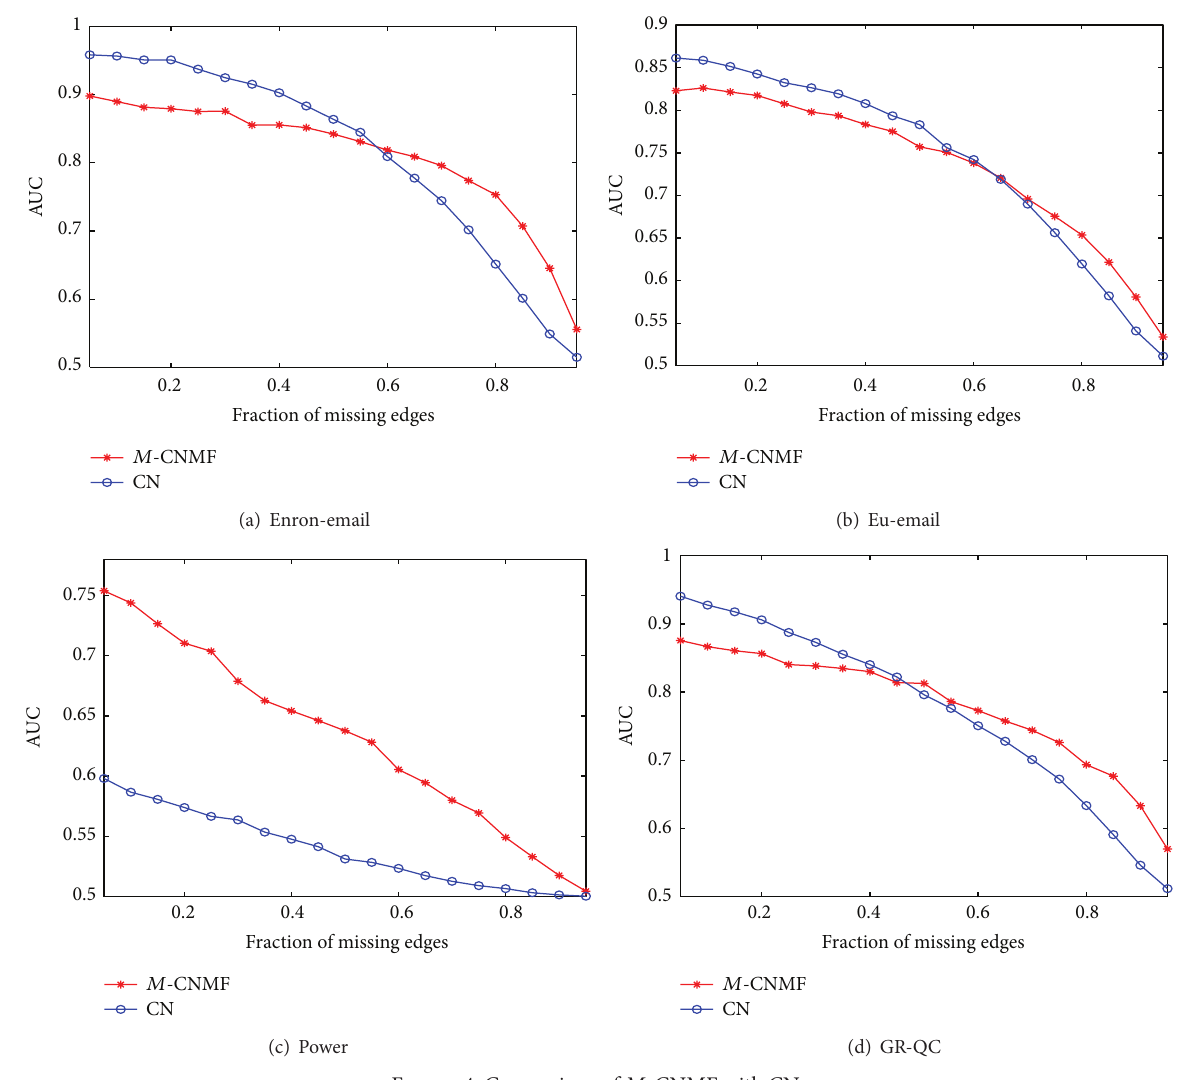
Figure 4: Comparison of 𝑀 -CNMF with CN.